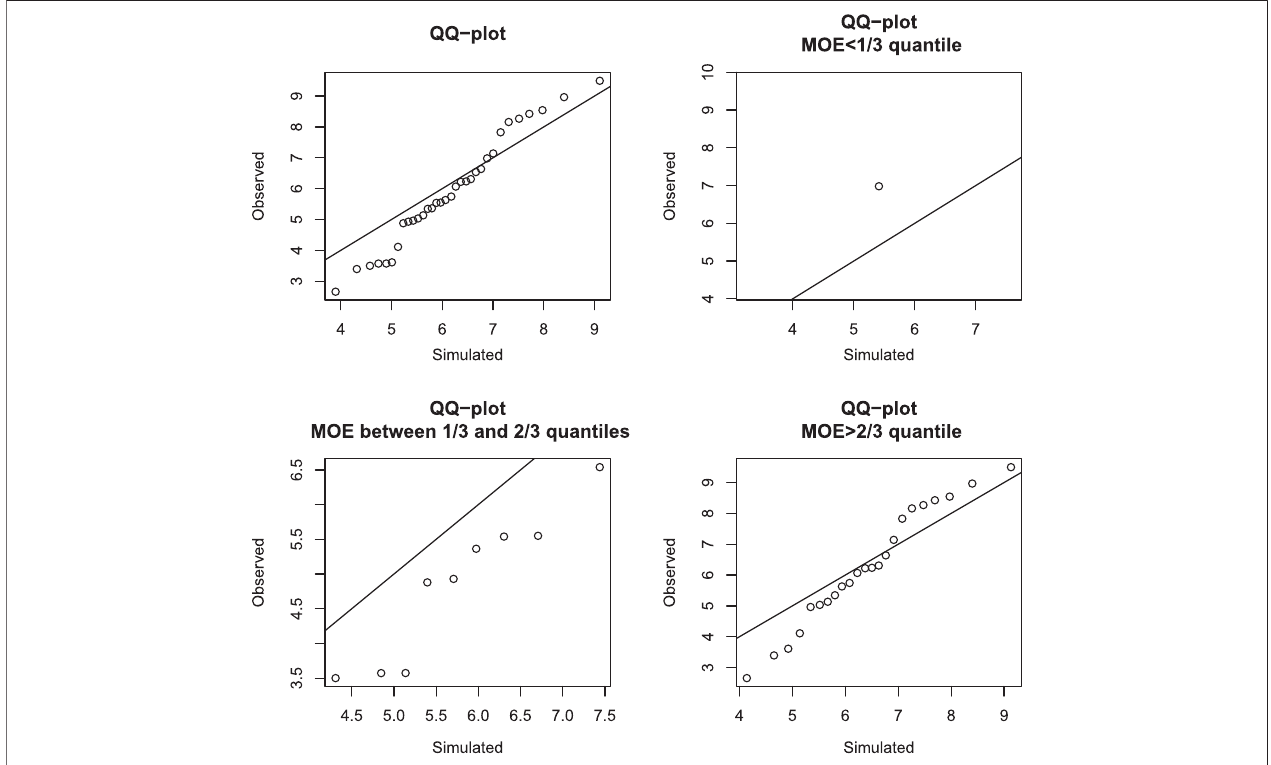
FIGURE 7 | Gaussian copula model and R60. Q-Q plot of observed residual UTS against simulated UTS with the identity line, given MOR greater than its 60 th quantile and MOE in different quantile intervals.